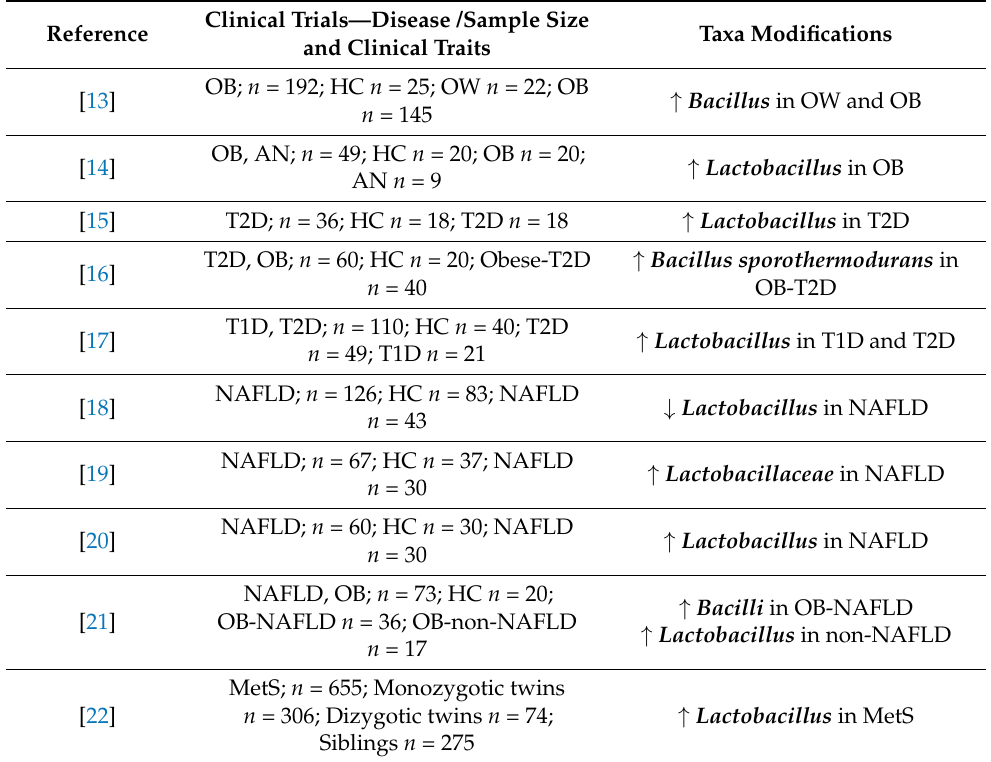
Table 1. Bacilli taxa modifications from clinical trials of metabolic related